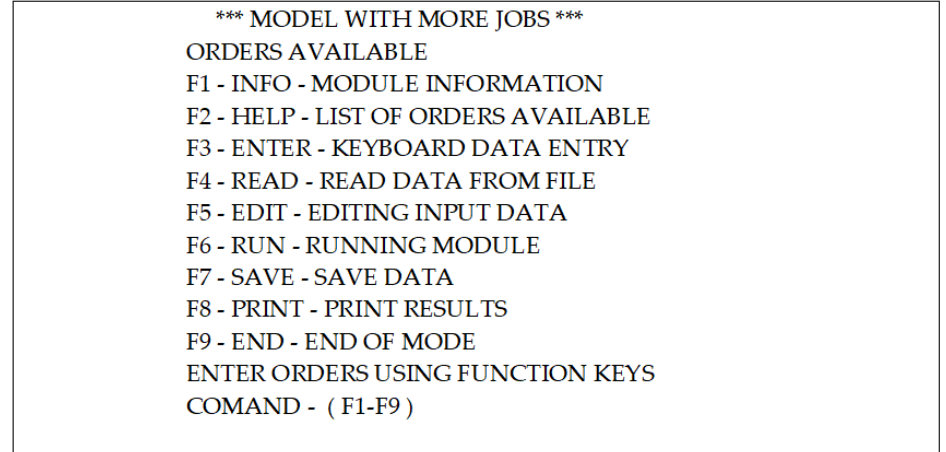
Figure 5. Data entry stage with the options.